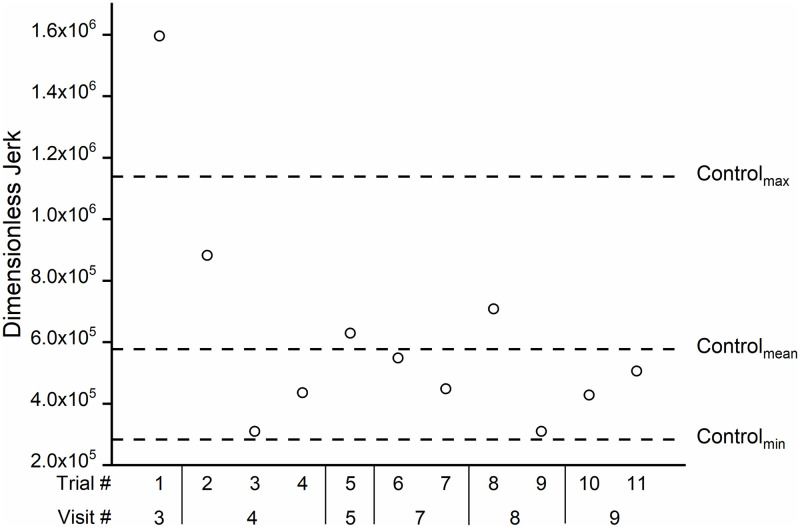
Dimensionless jerk values for stacking task trials.Dimensionless jerk values for stacking task trials for the mainparticipant across practice (smaller jerk values indicate smoothermovements). Trial 3 (visit 4), trials 5 (visit 5) and 8 (visit 8)were incomplete in which the main participant was unable tosuccessfully place the last block due to dropping it outside thereach of robotic arm.